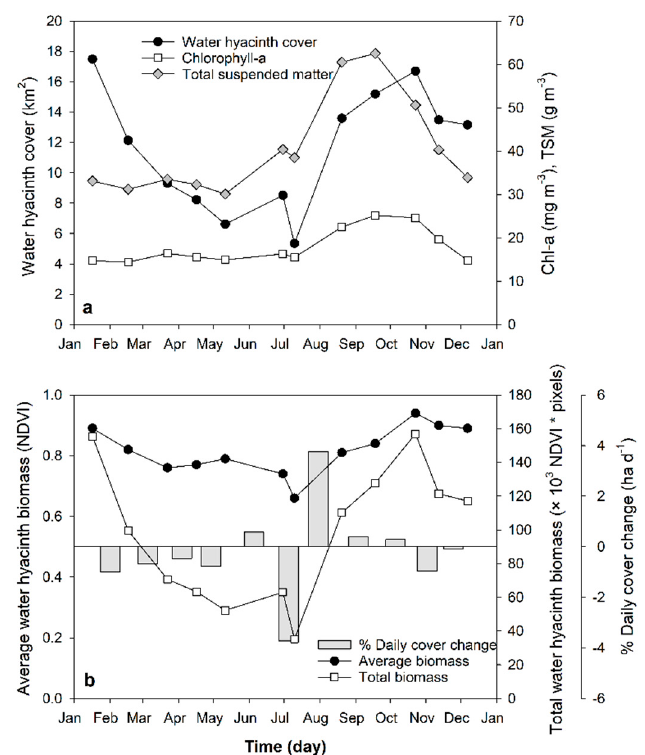
Figure 8. Temporal evolution of ( a ) Chlorophyll-a (Chl-a, mg m − 3 ), total suspended matter (TSM, g m − 3 ), and water hyacinth cover (ha); ( b ) average water hyacinth biomass (NDVI) and water hyacinth biomass scaled to total cover (NDVI * cover) in Lake Tana during 2020. X-axis represents the days during the year on a linear scale. Thus, major tick marks correspond to the 1st of each month and data points are shown based on the actual date of sampling, whereas bars are set at the midpoint between two consecutive samplings.